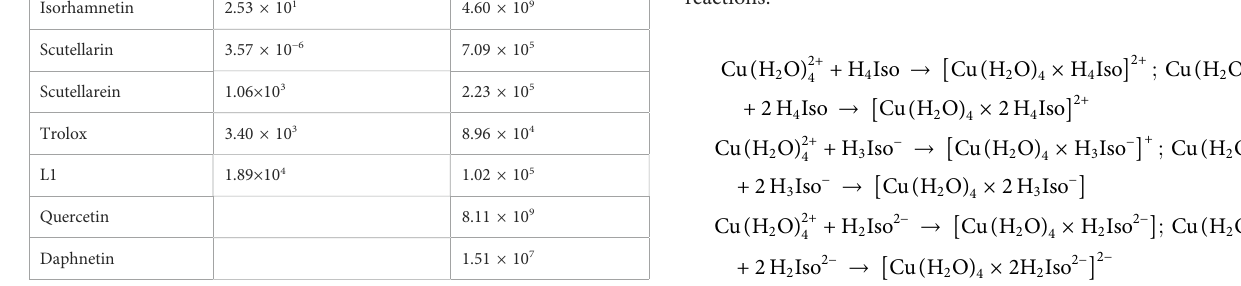
TABLE 4 K overall values of Isorhamnetin and other structurally similar antioxidant against the OOH radical. Value are in M − 1 s − 1 . Molecules k (lipid-like) overall